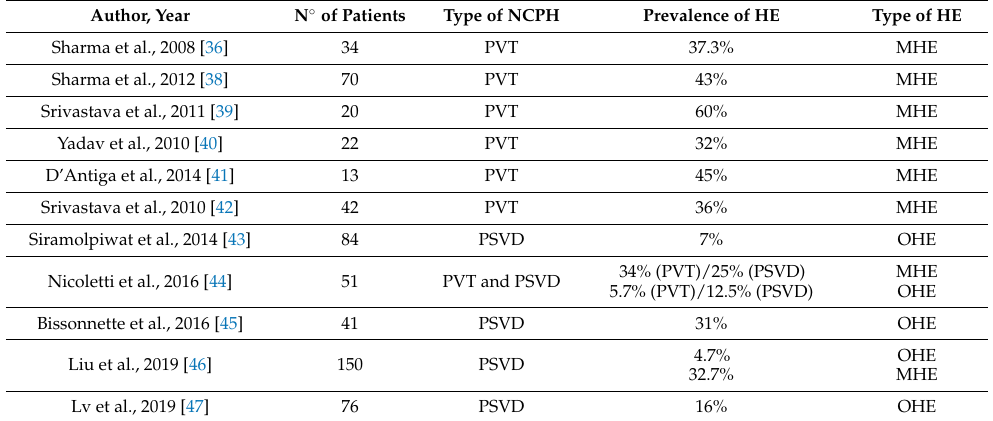
Table 1. Published studies on hepatic encephalopathy in patients with non-cirrhotic portal hyperten- sion (NCPH): chronic portal vein thrombosis (PVY) or porto-sinusoidal vascular disease (PSVD). Author, Year N ◦ of